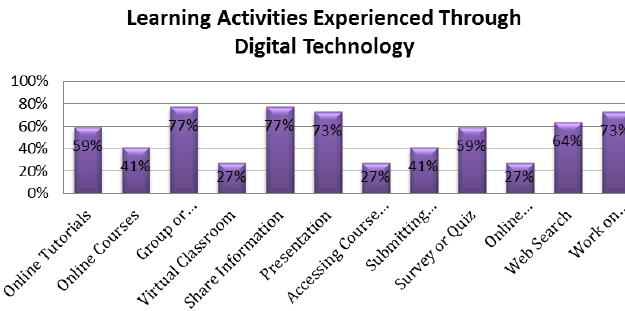
FIGURE 3 | Learning Activities Experienced by Students through Digital